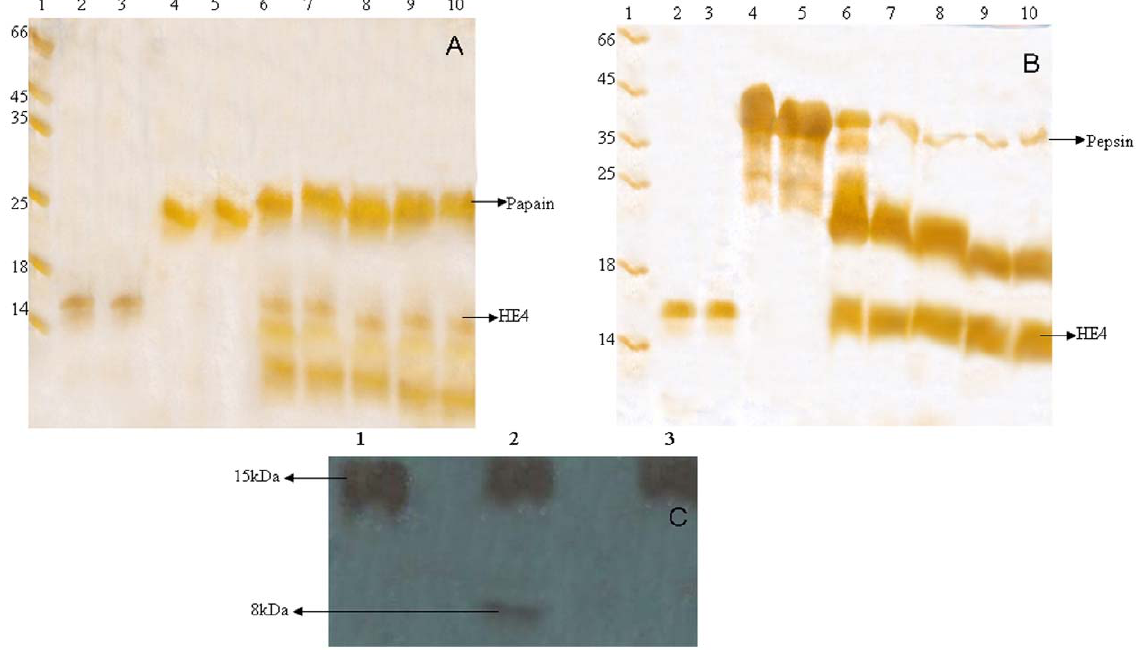
Figure 7. 14% SDS-PAGE to resolve HE-4 and pepsin, papain incubated alone or together for the same duration. ( A ) 14% SDS-PAGE (silver stained) Lane1: Molecular weight marker. Lane2: Fresh HE-4. Lane3: HE-4 after 1 hr incubation. Lane 4: Fresh papain. Lane5: papain after 1 hr incubation. Lane 6- Lane 10 papain and HE-4 in 1:1–1:5 (10 m g:10 m g-10 m g:50 m g) ratio after 1 hr incubation (in 50 mM tris-HCl buffer, pH 8.5). ( B ) 14% SDS-PAGE (silver stained) Lane1: Molecular weight marker. Lane2: Fresh HE-4 (10 m g). Lane3: HE-4 after 1 hr incubation (10 m g). Lane 4: Fresh pepsin (10 m g). Lane5: pepsin (10 m g) after 1 hr incubation. Lane 6- Lane 10 pepsin and HE-4 in 1:1–1:5 ratio (10 m g:10 m g–10 m g:50 m g) after 1 hr incubation (in 50 mM sodium acetate buffer, pH 5.0). ( C ) Immunodetection of HE-4 after incubating HE-4 alone and with pepsin and papain for the same duration. Lane1: HE-4 (10 m g) after 1 hr incubation. Lane 2: HE-4 (10 m g) after 1 hr incubation with papain (10 m g) and Lane3: HE-4 (10 m g) 1 hr incubation with pepsin (10 m g).